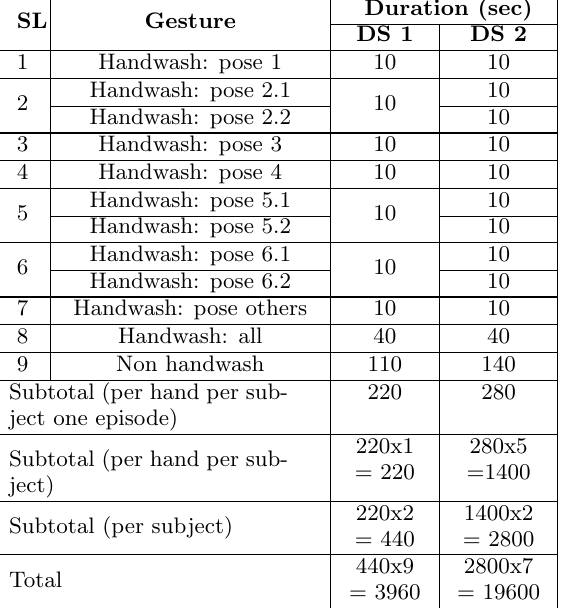
Table 1: Duration of ground truth